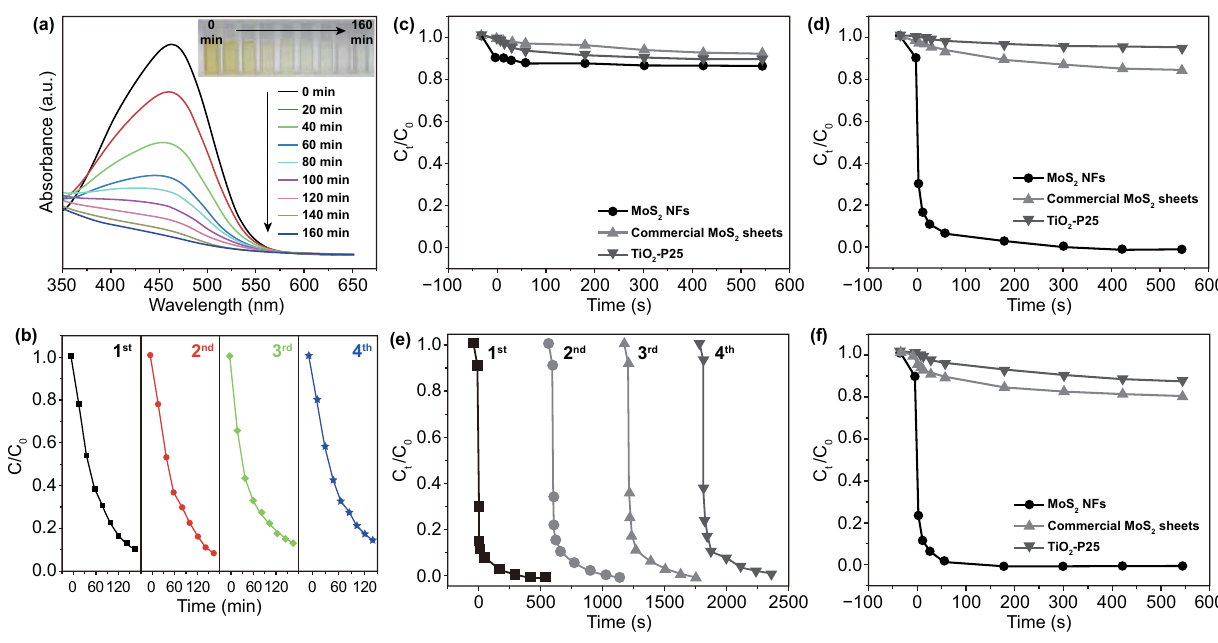
Fig. 7 a , b UV–Vis absorption spectra of the MO aqueous solutions sampled in BTO nanowires at set intervals. Inset: photograph of the MO solutions samples; plots of the relative intensity of the maximum absorption at 460 nm as a function of reaction time in four recycling processes. Reproduced with permission [101]. Copyright 2018, Elsevier. c – f The degradation ratio of the RhB dye using the MoS 2 nanoflowers, commer‑ cial MoS 2 , and TiO 2 –P25, under different degradation conditions: c in the dark, d ultrasonic wave in the dark, e the repeatable degradation tests of the RhB dye using the MoS 2 nanoflowers under ultrasonic‑wave assistance in the dark, f degradation ratio of the RhB dye under ultrasonic‑ wave assistance with the xenon lamp illumination using the MoS 2 nanoflowers. Reproduced with permission [72]. Copyright 2017,